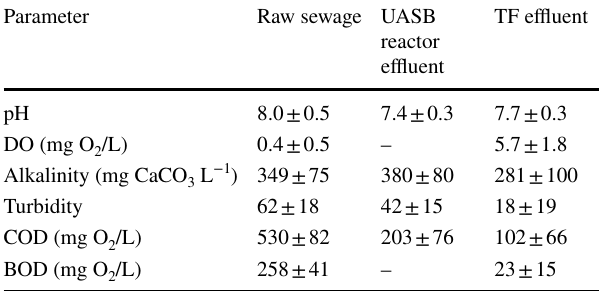
Table 1 Chemical and biological characteristics of samples